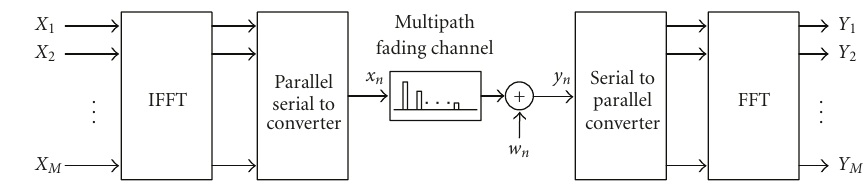
Figure 8: OFDM system model.